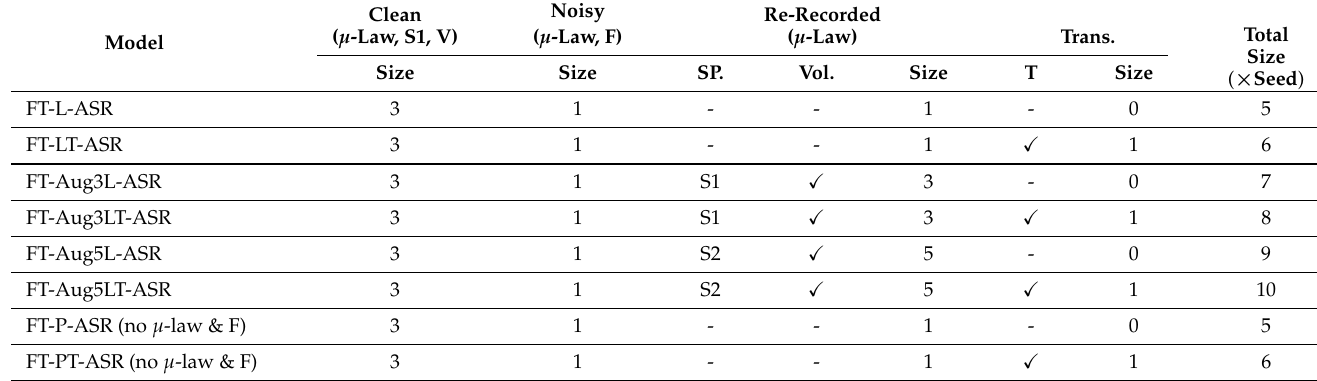
Table 3. Dataset for fine-tuning of Base-Aug3N-ASR. Notations: FT= fine-tuning, L = adapted by LTE re-recordings, P = adapted by pin mic re-recordings, S1 = speed perturbation (0.9, 1,